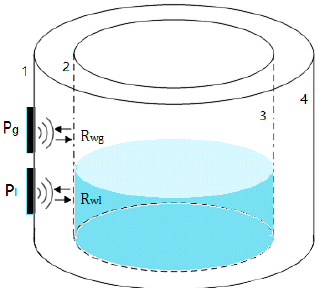
Figure 1. The measurement principle. P (cid:2917) and P (cid:2922) are the sound pressure relating to the echoes reflected by the inner surface of the